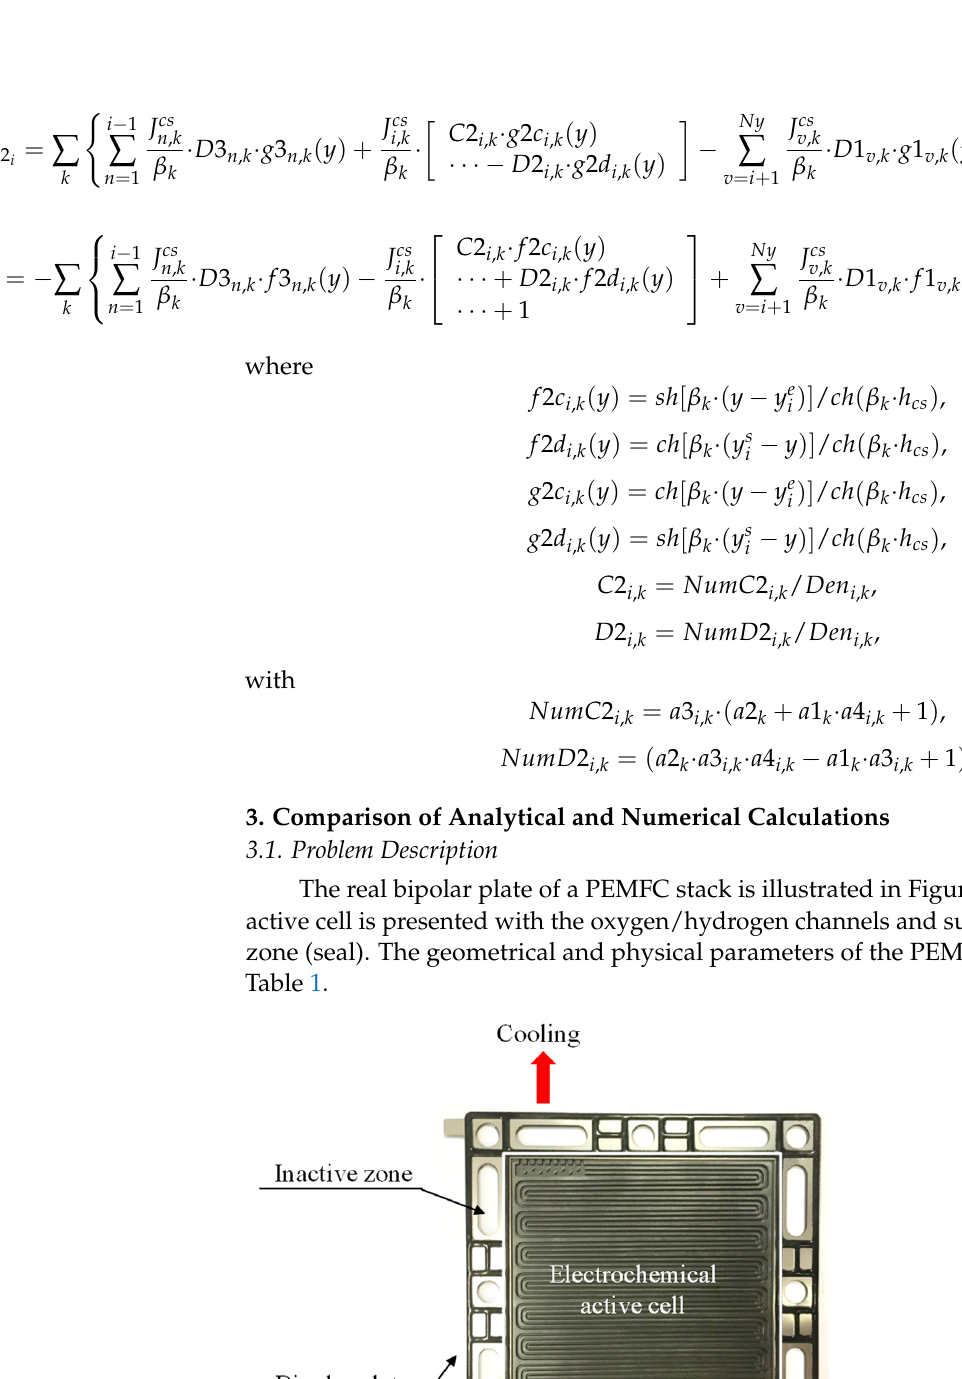
( b ) Figure 7. FC representation with a discretization of Ny Nx 25 20 500 × = × = conductive segments for: ( a ) a healthy FC, and ( b ) an FC failure. Such an important discretization is necessary due to the channels’ size (viz., ~0.8 mm) as shown in Figure 6. The total current flowing through the PEMFC stack (of surface fc S = 196 cm 2 ) is considered constant and equal to fc I = 70 A. With an electrochemical active cell surface of a S = 100 cm 2 , for a healthy FC [see Figure 7a], this corresponds to cs max J = 0.7 A/cm 2 . An example of an FC failure, which can be a consequence of different operating problems, is exposed in Figure 7b. Considering 500 initial conductive segments, 144 seg- ments are faulty (i.e., cs max J = 0 A/cm 2 ), so 356 conductive segments present a current den- sity of cs max J = 0.983 A/cm 2 . To evaluate the capacity and the efficacy of the 2D analytical model, the two operat- ing conditions (i.e., normal and faulty condition) are simulated and compared to 2D FEA. The geometrical and physical parameters described previously are simulated on FEMM software [38]. The FE calculations are performed with the same assumptions as the ana- lytical model [see Section 2.2]. The infinite box surface has been imposed to fc S 3 S = ⋅ =